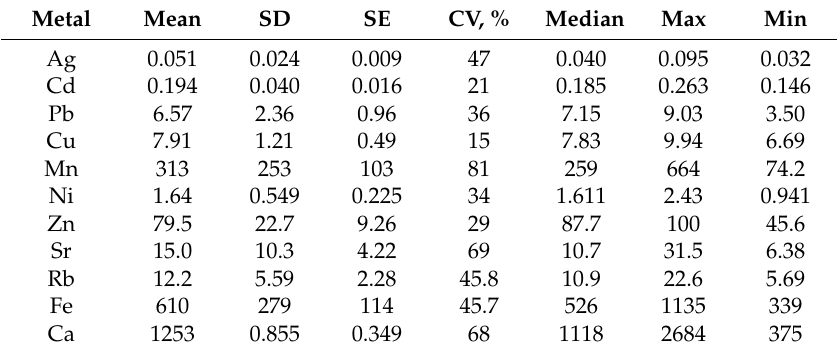
Table 2. Concentrations of trace elements in the H . physodes thallus, the Sambian peninsula, µ g/g DW.